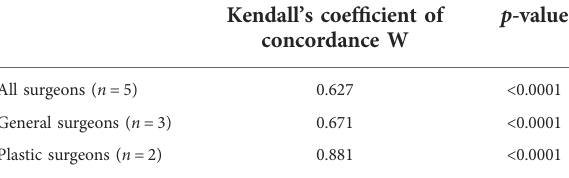
TABLE 6 Kendall ’ s coef fi cient of concordance ( N =186). Kendall ’ s coef fi cient of